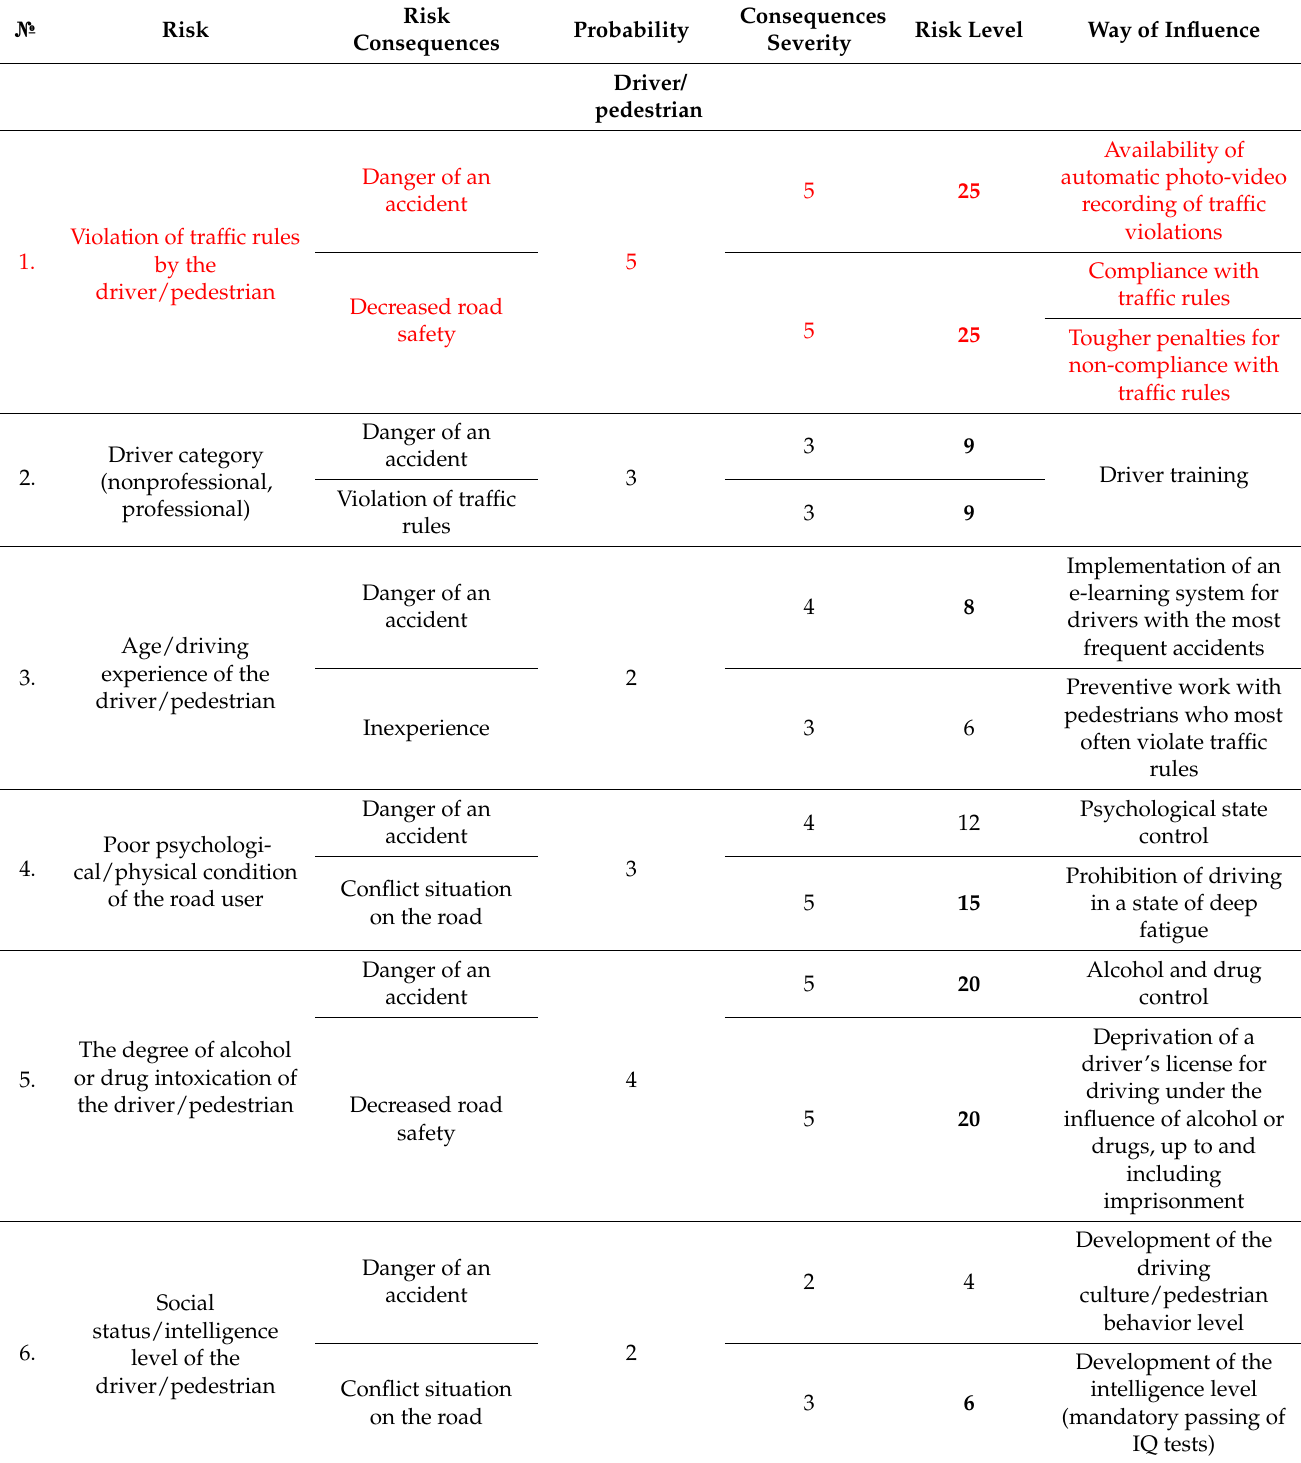
Table 3. Summary table of the risks that must be taken into account to increase traffic